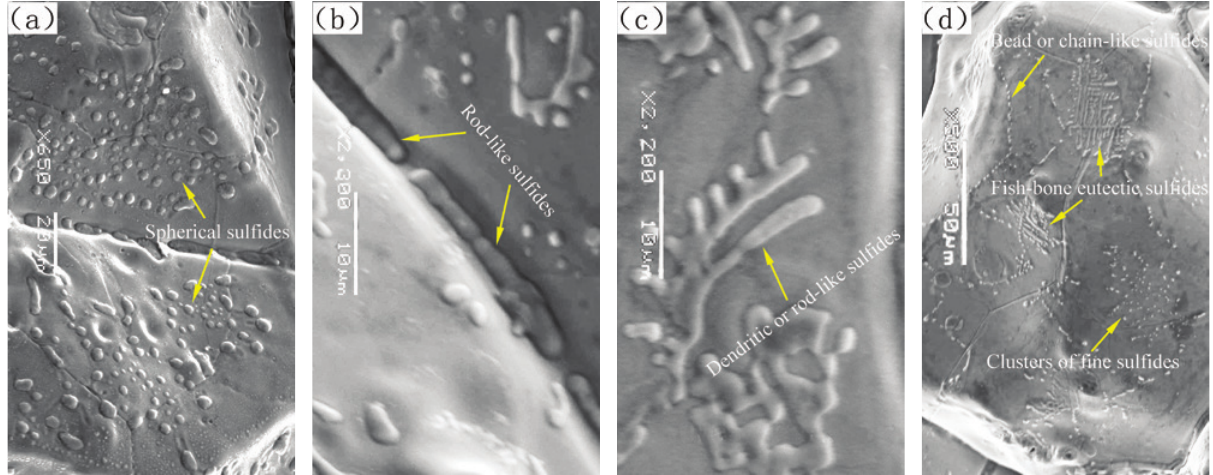
Fig. 6: Typical morphologies of the sulfide inclusions on the surface of fractures in steel 1: (a) spherical sulfides; (b) rod-like sulfides; (c) dendritic or rod-like sulfides; (d) bead or chain-like, fish-bone eutectic, and clusters of fine